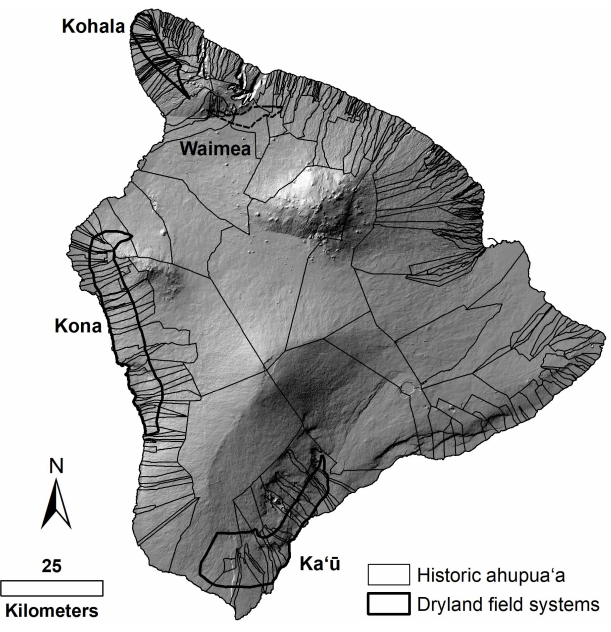
Fig. 1 . Map of the rain-fed Kohala, Kona, Ka ʻū , and Waimea field systems’ extents depicted in Ladefoged et al. (2009) with elevation-based hillshade (State of Hawai ʻ i Office of Planning 2003) and ahupua ʻ a boundaries (Office of Hawaiian Affairs